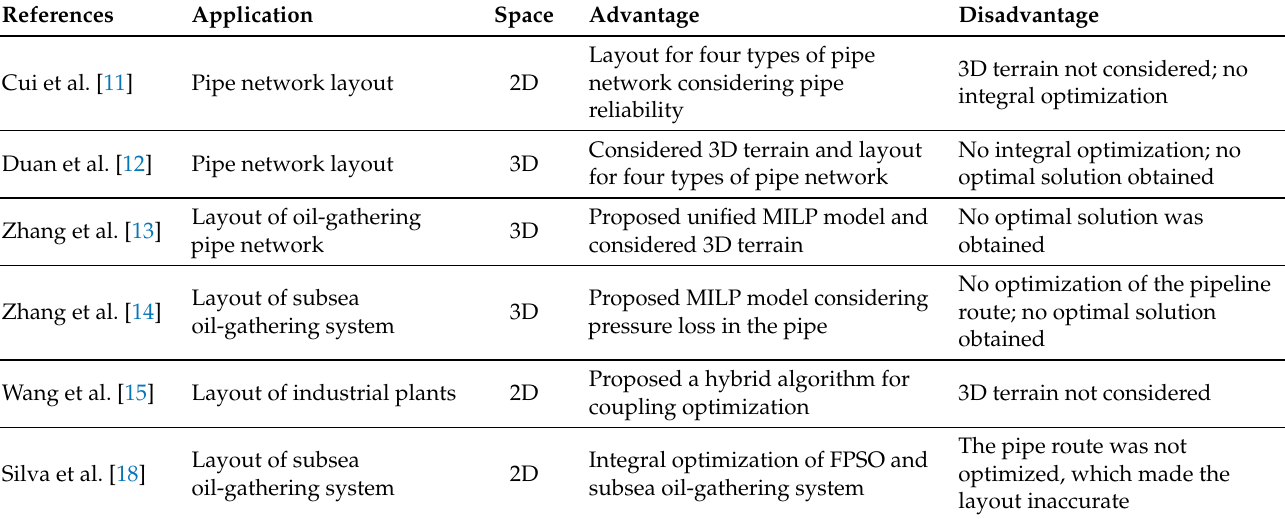
Table 1. Comparisons between recent studies investigating the layout